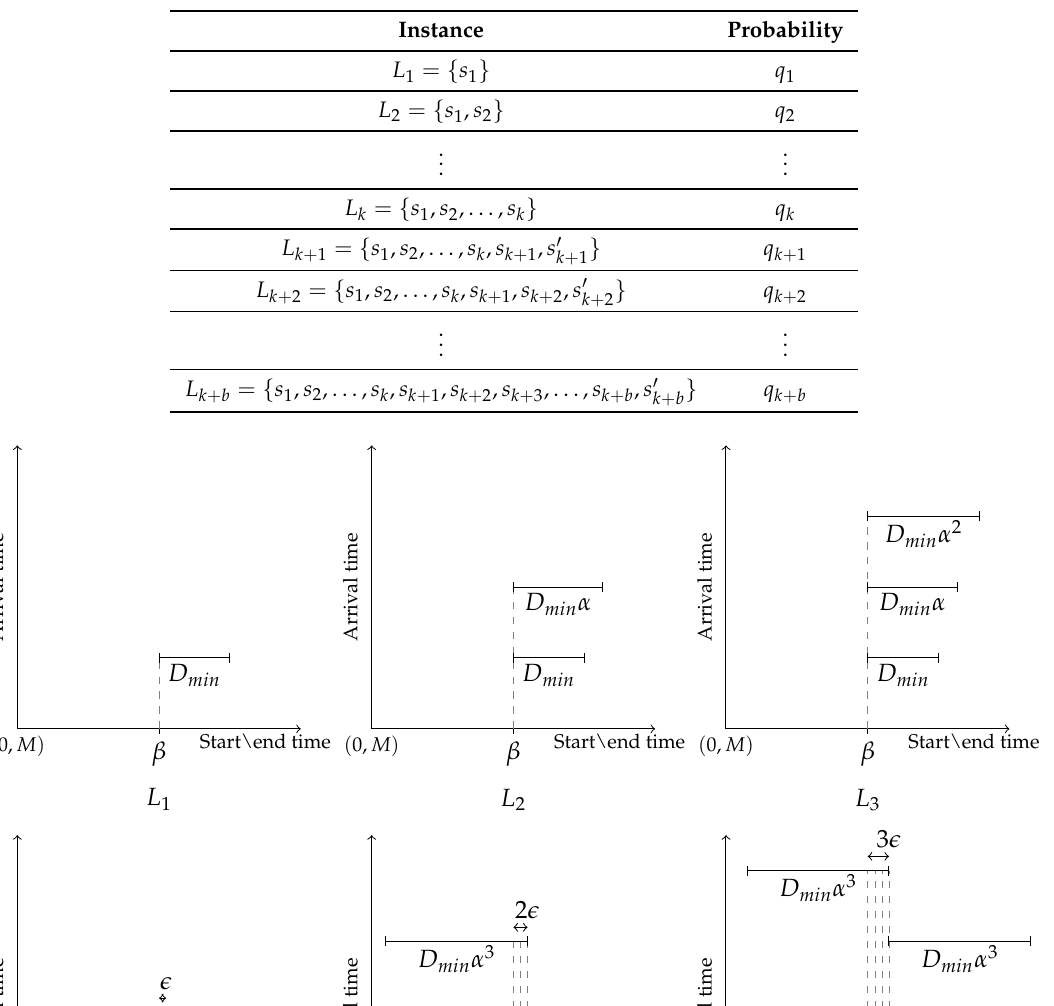
Table A2. Probability distribution Q over K . { s 1 , s 2 , . . . } represents a sequence with jobs from s 1 placed first, then from s 2 , and so on. The arrival times of the jobs are such that the jobs in each of L 1 , L 2 , . . . , L k + b are ordered by their arrival times.